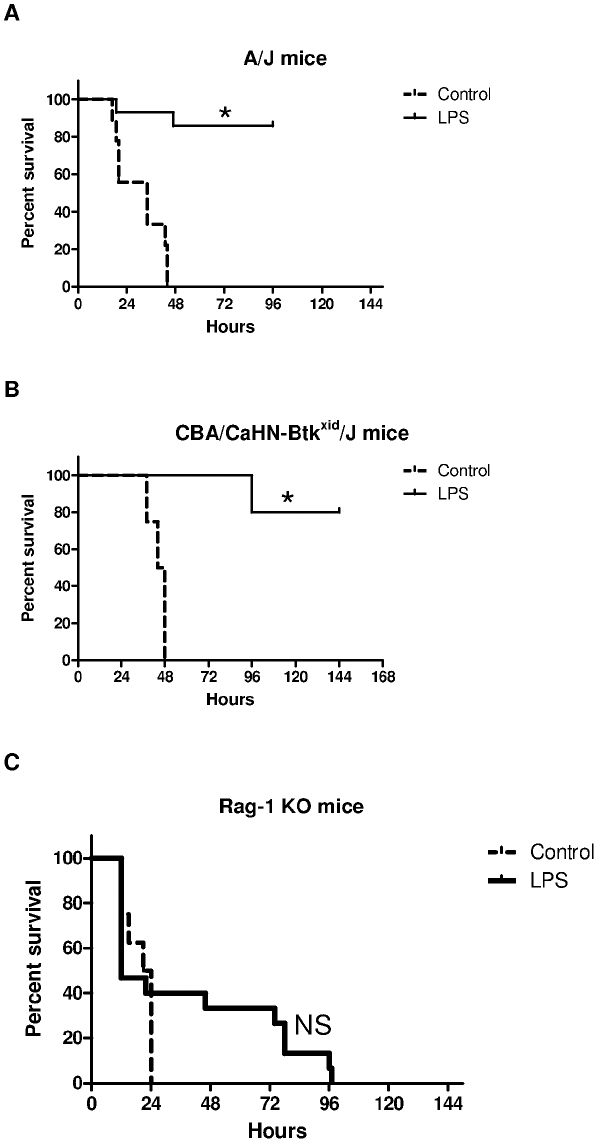
Figure 7. Survival curves for LPS pretreated and PBS control (A) A/J, (B) CBA/CaHN-Btk xid/ /J, and (C) Rag-1 KO mice after challenge with S.pneumoniae (n=4 – 14 mice per group), *log- rank test, p ,